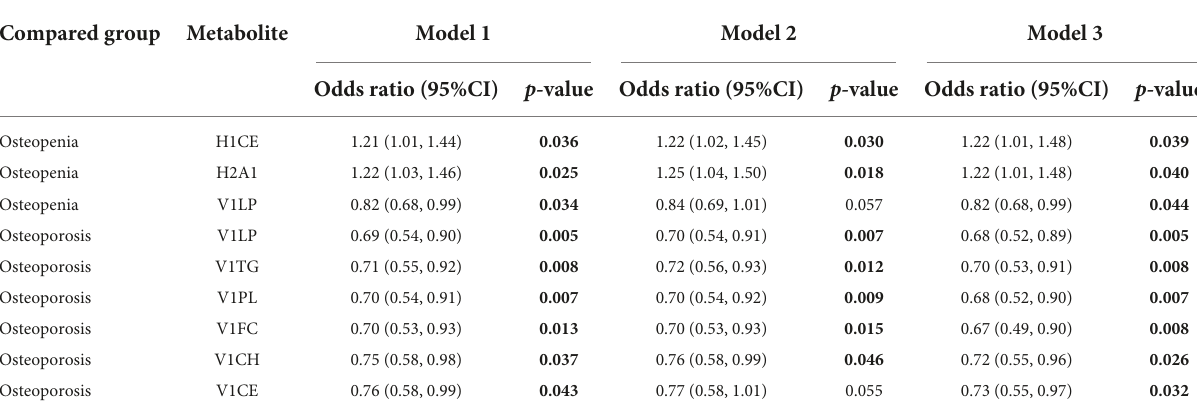
TABLE 2 Comparison of metabolites between